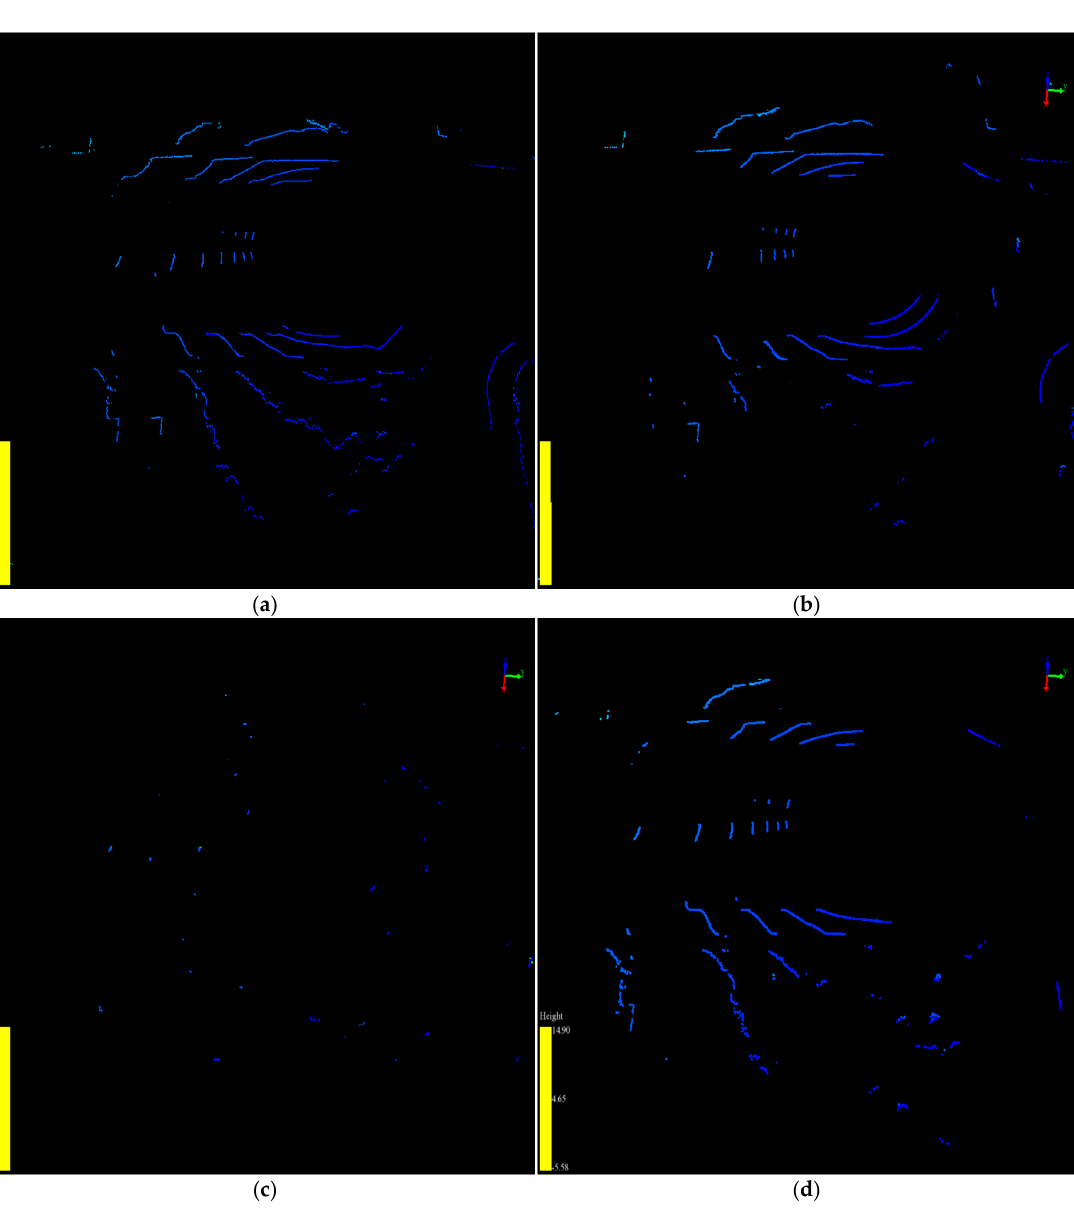
Figure 18. The AGPs before and after filtering are shown in VeloView. ( a ) The raw AGPs before filtering. ( b )The AGPs after being filtered by RANSAC; ( c ) The AGPs after being filtered by 3D-DSF; ( d ) The AGPs after being filtered by SPF.